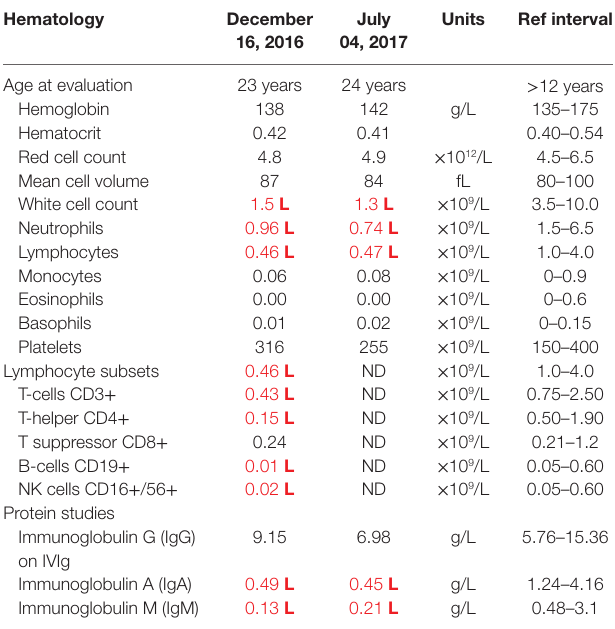
taBLe 2 | Hematology laboratory workup for the proband. Hematology